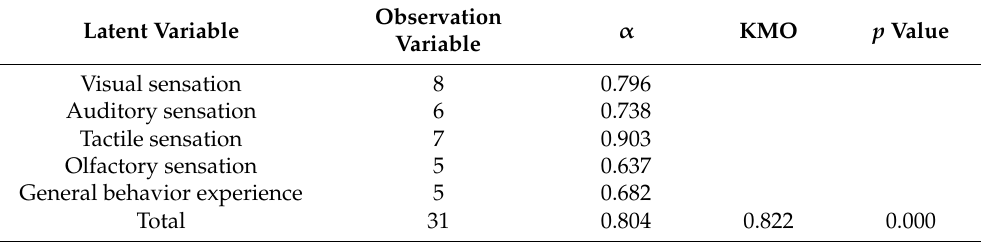
Table 1. Reliability and validity analysis.